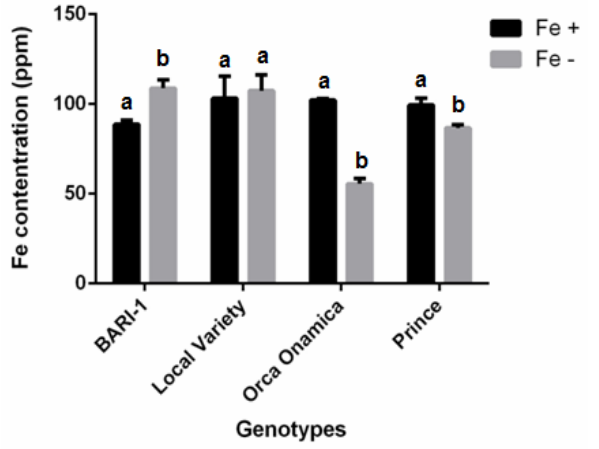
Fig. 2. Fe concentration in young leaves in a number of okra genotypes grown in Fe-sufficient (Fe+) and Fe-deficient (Fe-) hydroponic culture. Data were taken 3 weeks after Fe deficiency was imposed. Different letters indicate significant differences between means ± SD of treatments (n =